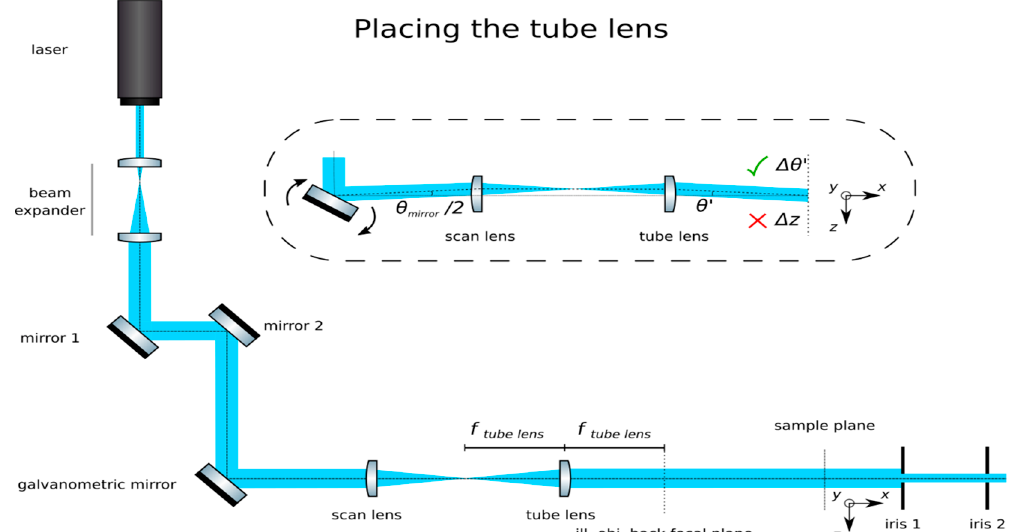
Figure 5. Placing the tube lens. The tube lens should produce a beam expander with the scan lens. If placed correctly, a well collimated beam will be achieved and, at the its focal plane, which will coincide with the illumination objective’s back focal plane, rotations of the mirror will produce rotations ( Δ 𝜃 ), but not translations ( Δ z) of the beam.